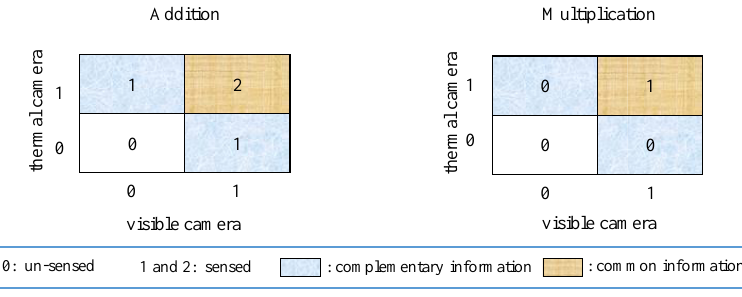
Figure 3. The illustration of element-wise addition ( ⊕ ) for extracting the cross-modal complementary information and element-wise multiplication ( ⊗ ) for extracting the cross-modal common information.